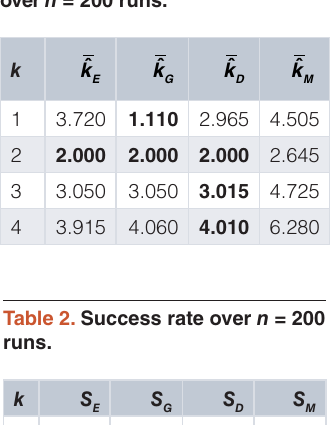
Table 6. Average error size (when wrong) over n = 200